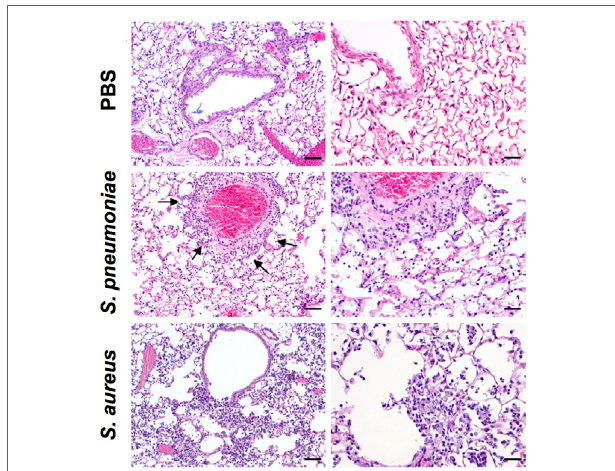
FigUre 2 | Histopathology (hematoxylin and eosin) of lung tissue obtained from BALB/c mice intranasally inoculated with either Streptococcus pneumoniae (middle panels) or Staphylococcus aureus (lower panels) or with only PBS (upper panels) at 24 h after treatment. Black arrows indicate peribronchial cellular infiltration. Lower magnification images are shown in the left panels and higher magnification images in the right panels. Original magnification: bar indicates 50 µm for left panels and 25 µm for right